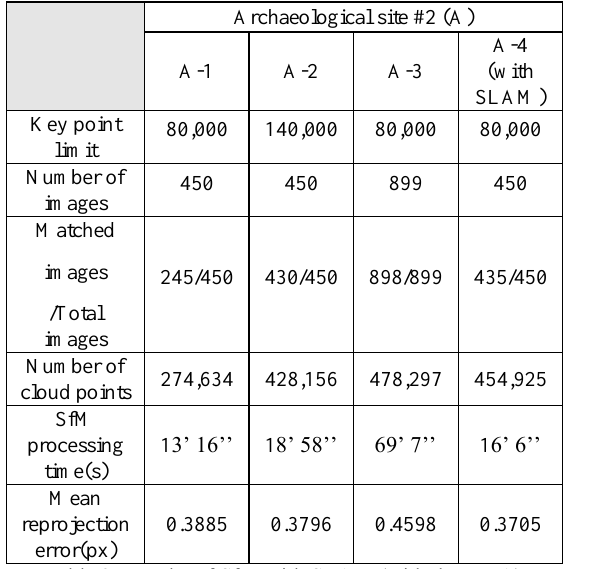
Table 2. Results of SfM with SLAM (with dataset A)